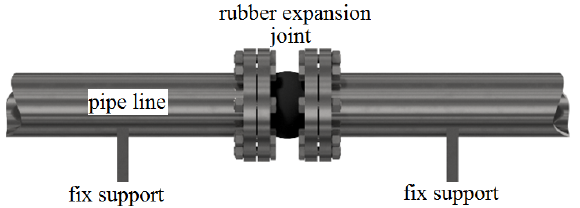
Figure 3: Scheme of the installation of the expansion joint in pipeline system